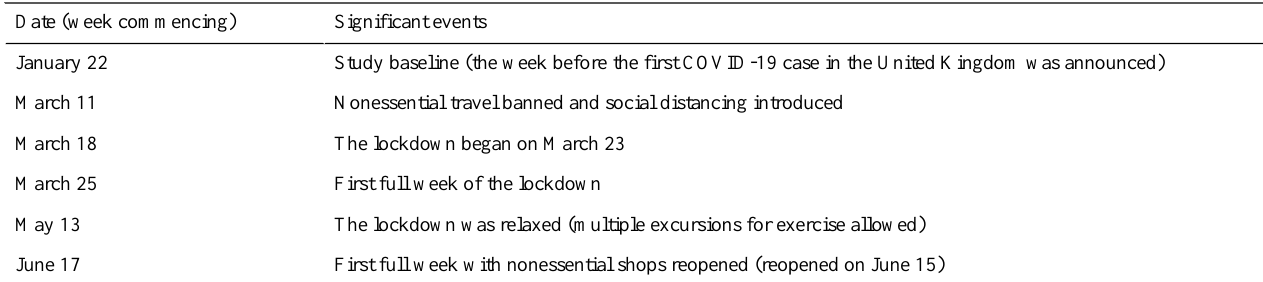
Table 1. Baseline and follow-up measurement dates for